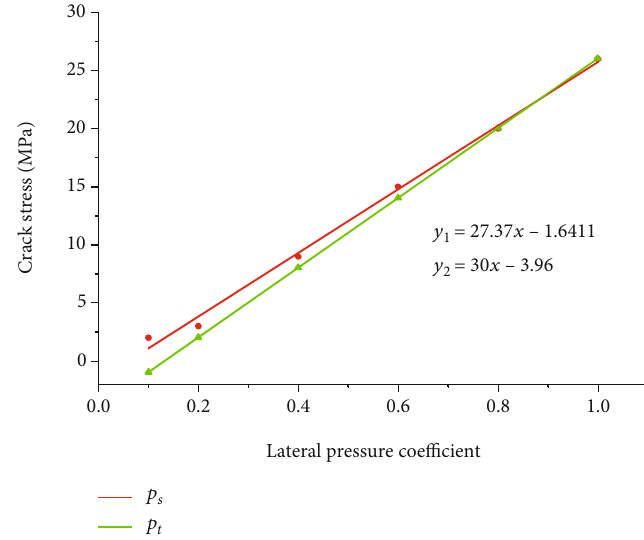
Figure 11: The relationship between crack initiation pressure and lateral pressure coe ffi